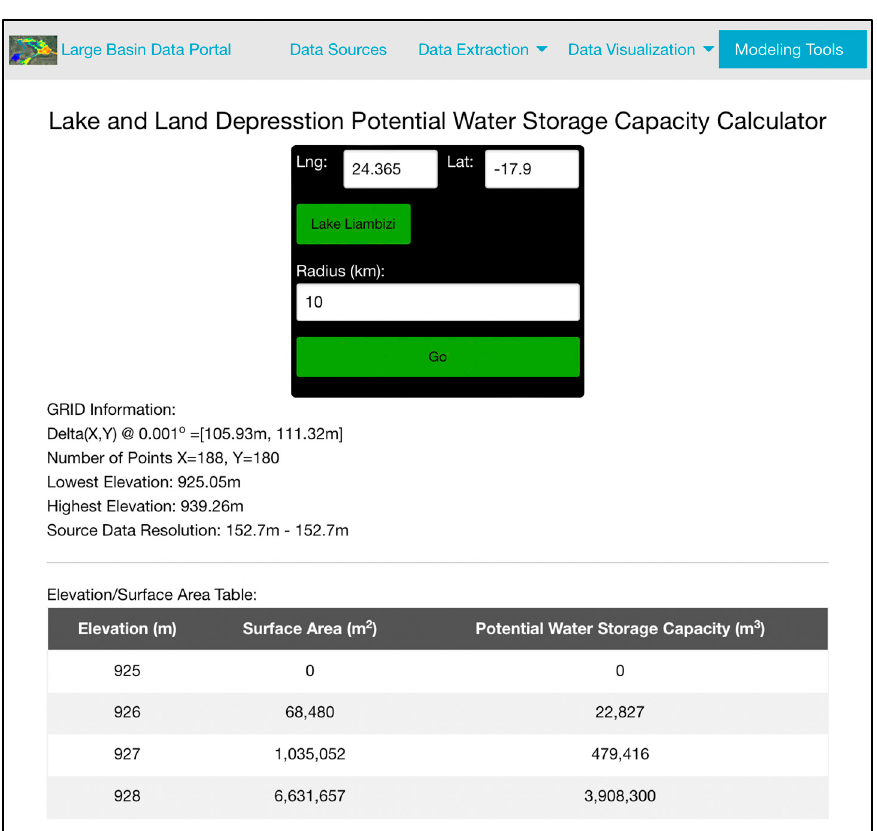
Figure 11. Screenshot of the lake storage calculator and a sample output for Lake Liambezi at the border of Botswana/Namibia showing the calculated lake water surface area and potential storage capacity when water levels increase from 925 m to 928 m above sea level. Data are derived from the Google Maps Elevation dataset.